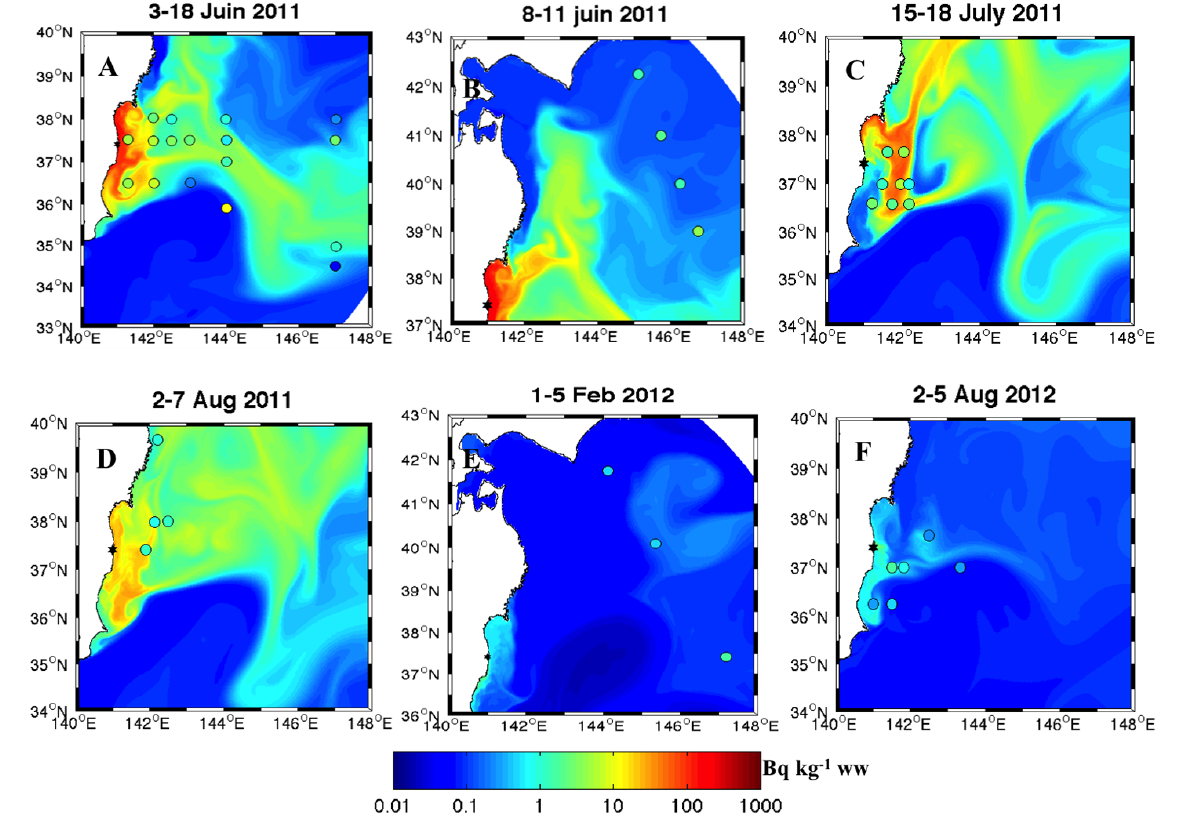
Figure 5. Spatial and temporal comparisons between the weighted average of simulated 137 Cs concentrations in the three zooplankton groups (Bqkg − 1 ww) and the field observations (colored rounds) reported by (a) Buesseler et al. (2012), (b, c, d, f) Kaeriyama et al. (2014) and (e) Kitamura et al.